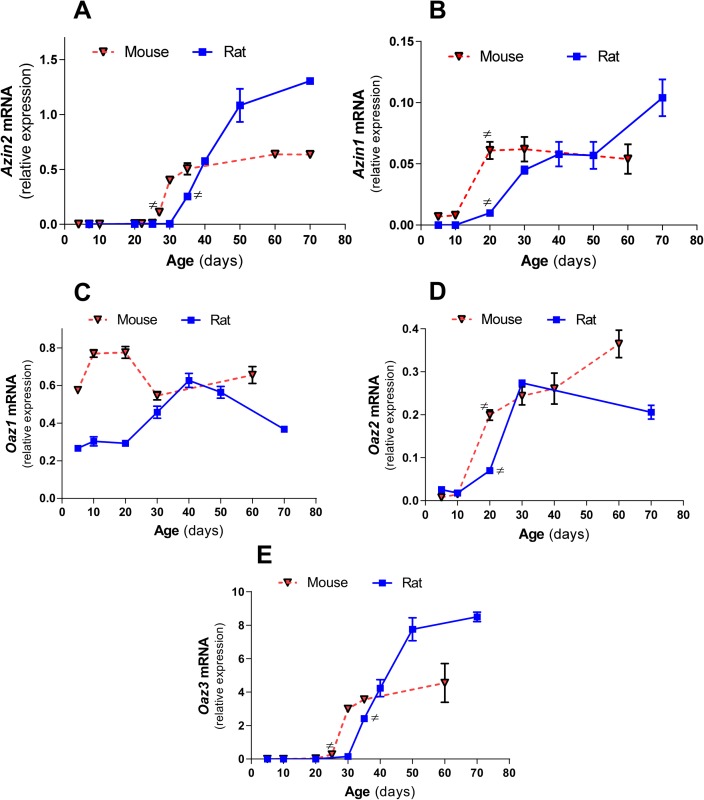
Comparative expression of ODC mRNA levels of Azins and Oazs in the testes of mice and rats during the postnatal period.mRNA levels were determined by real time RT-PCR. Expression values were normalized with respect to β-actin. Data represent mean±SEM of 2–3 animals per group until day 10, and 3–4 animals per group thereafter. Note that for all genes examined, except for Oaz1, the maximal increases in gene expression in mice took place before those of rats. (#) First value in the time series that is significantly different (P<0.01) from its precedent value.